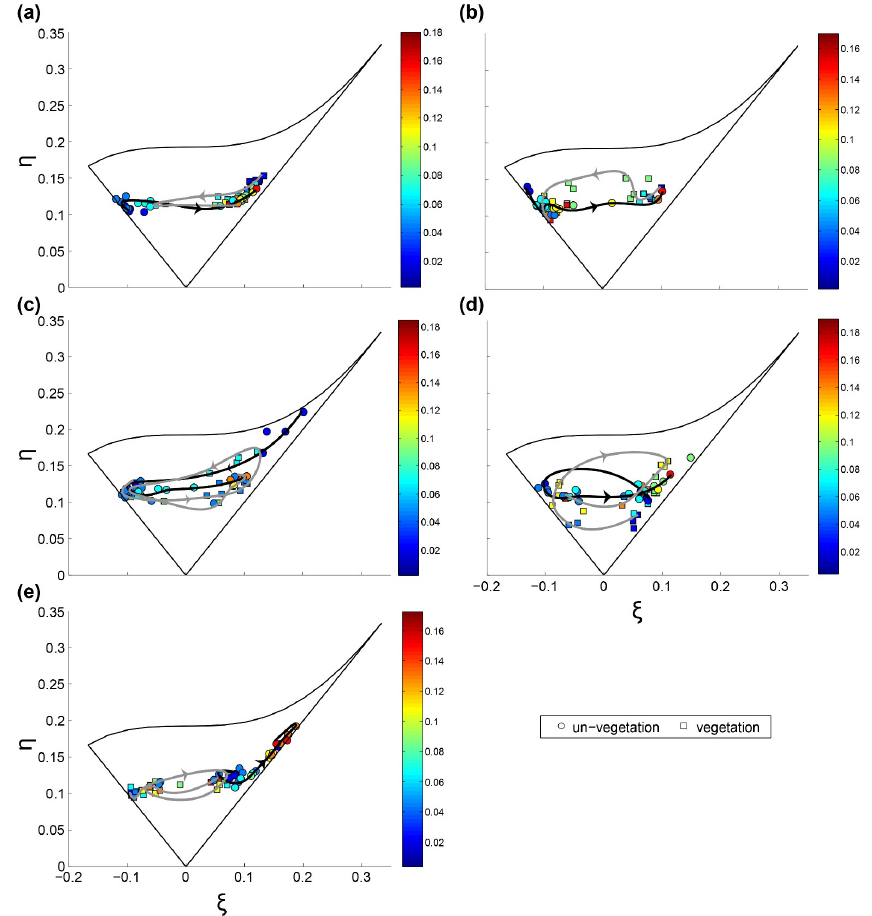
Figure 20. Maps of the anisotropic invariant for the cases of the un-vegetated bed (labeled by circular shapes) and vegetated bed (labeled by rectangular shapes) at the azimuthal sections of θ = ( a ) 30 ◦ , ( b ) 60 ◦ , ( c ) 90 ◦ , ( d ) 120 ◦ , ( e ) 160 ◦ with a constant distance from the abutment (4 cm). The depth of the measurement is color-coded in meters. The distribution of the turbulence anisotropy for both cases of un-vegetated and vegetated bed throughout the water column is denoted by black and gray curves, respectively. The direction from the bottom to the water surface is indicated by the arrow- heads.